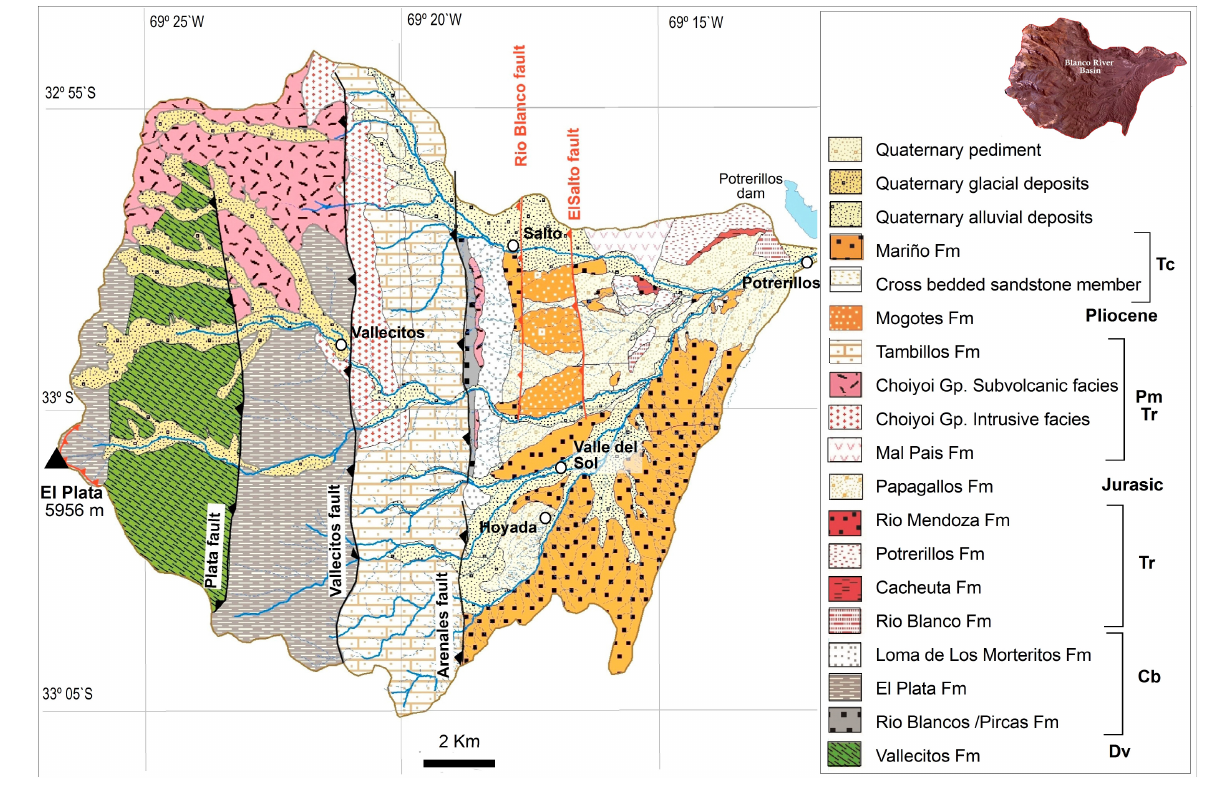
FIGURE 2 | Quaternary, Tertiary (Tc), Pliocene, Jurassic, Permo-Triassic (PmTr), Triassic (Tr), Carboniferous (Cb), and Devonian (Dv) lithological units outcropping in the BRB with the main structures of the Carrera fault system responsible for the Frontal Cordillera uplift. Rio Blanco (RBF) and Salto (SF) active faults are mapped in red color. The probable source area of the Plata rock avalanche is indicated in red line the headwater of the Angostura Valley at the Plata Mount (5,956 m asl). Dots indicate main